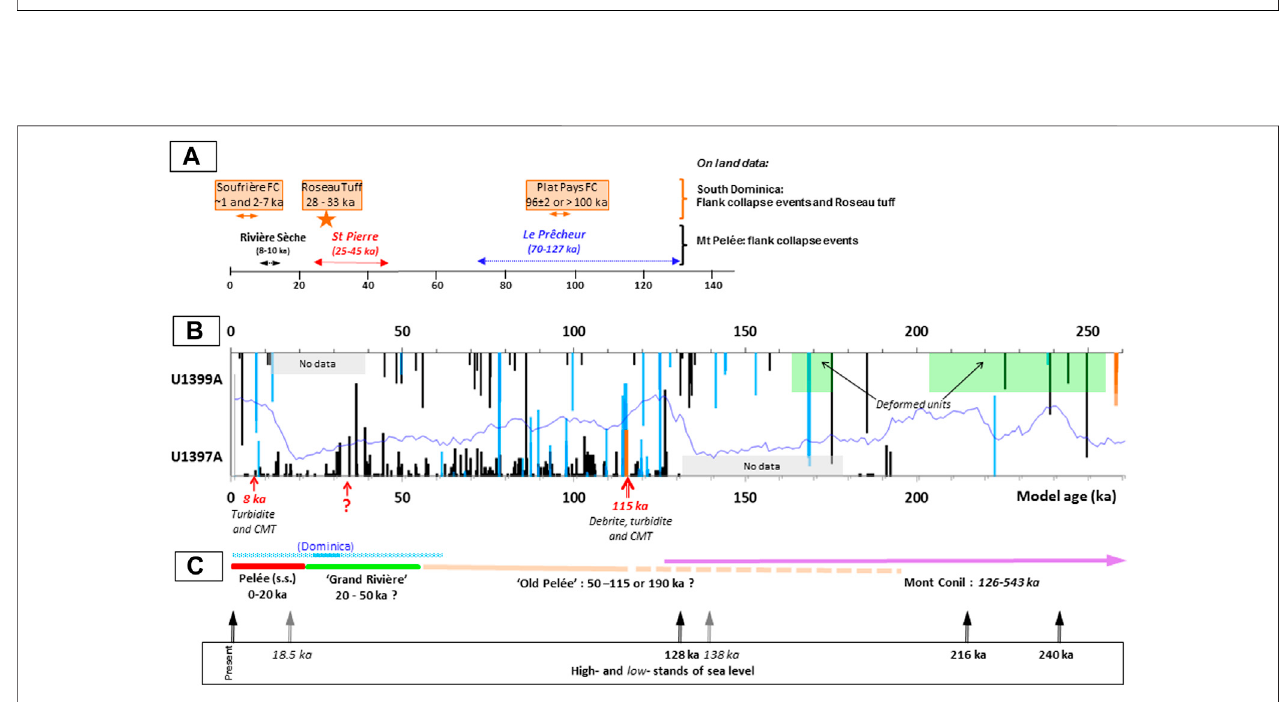
FIGURE 12 | Volcanic records on land (Mt Pelée and Dominica) and in cores U1397A and U1399A: 0 – 260 ka. (A) On-land data. (B) Core data. (C) Proposed chronologyofactivevolcaniccenters.Symbols anddatasourcesasin Figure9 .Redarrows in (B) refertopossible fl ankcollapses identi fi edonland andoffshore.CMT: coherent mass transport (duplicate units). Blue line: LR04 curves for comparison. Dashed lines indicate speculative extent of the volcanic activity.